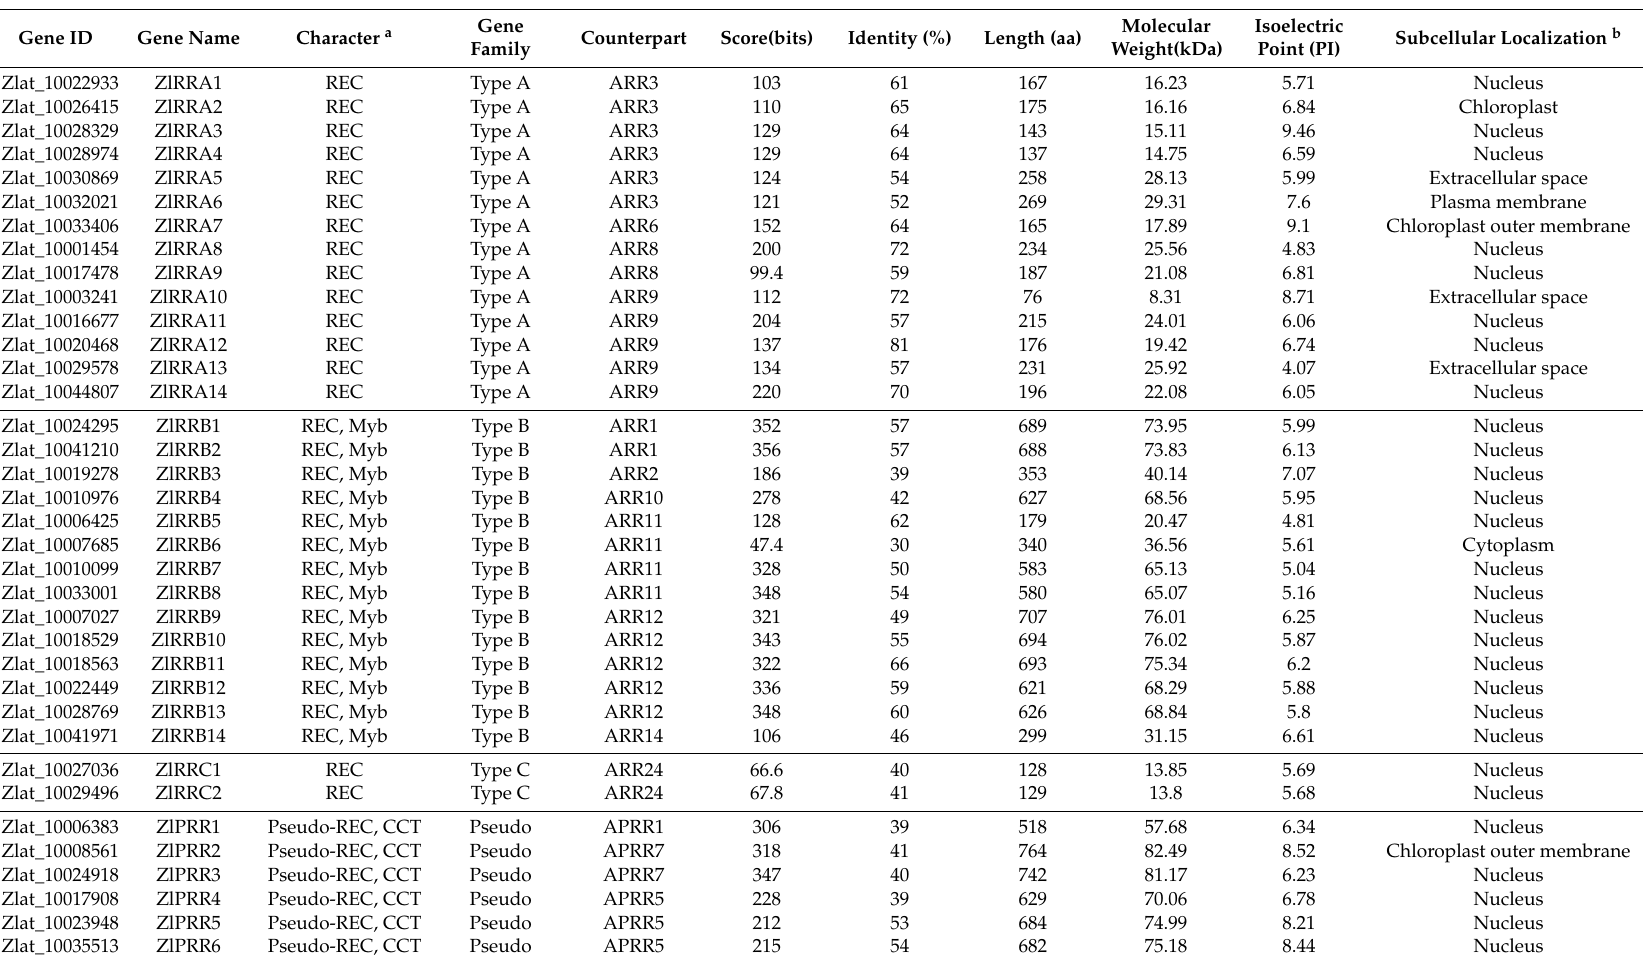
Table 3. Response regulator (RR) proteins in Z.